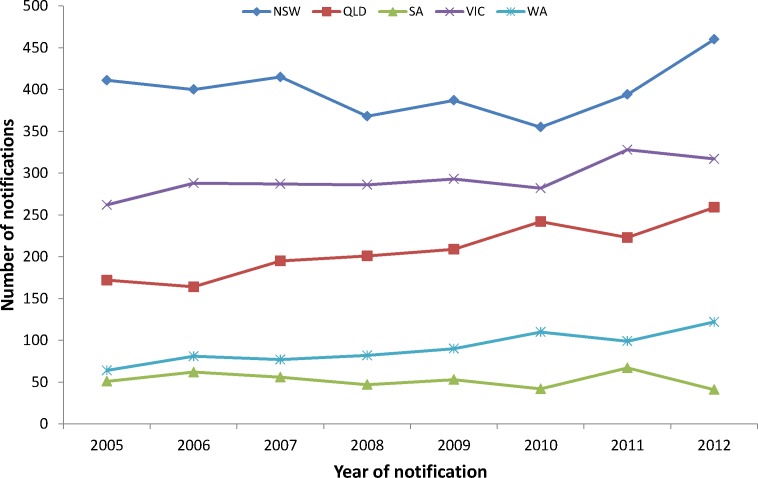
The number of new HIV-1 diagnoses by year for each Australian jurisdiction outlined in the Australian molecular epidemiology network; NSW = New South Wales, QLD = Queensland, SA = South Australia, VIC = Victoria and WA = Western Australia (Provided by the Kirby Institute [23]).